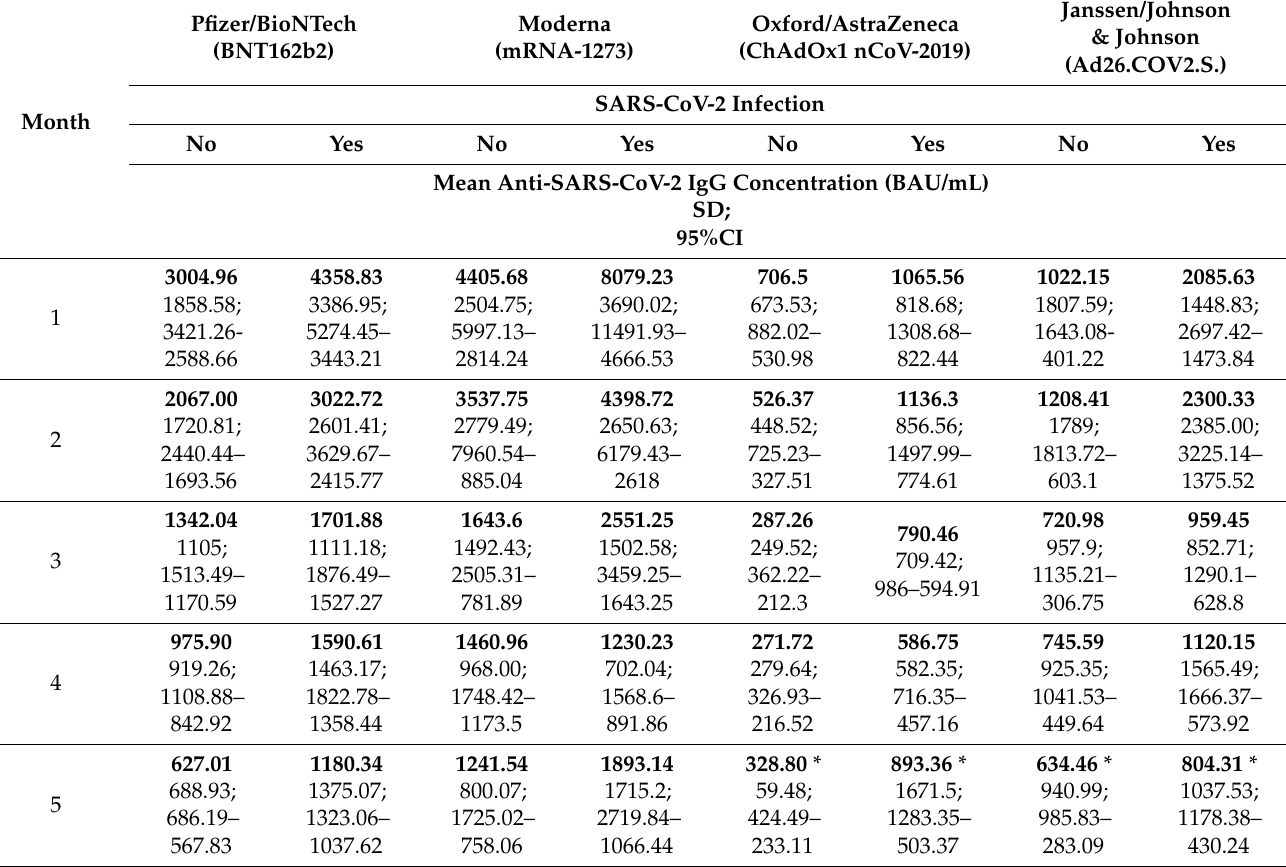
Table 5. Comparison of mean anti-SARS-CoV-2 IgG antibody titers among vaccines in the months following full